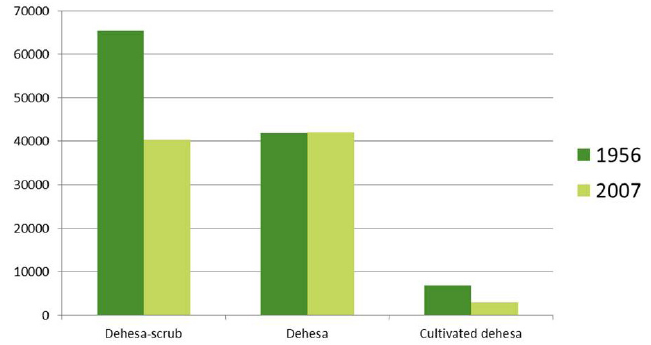
Figure 3: Changes in the three main types of dehesa (hectares). Source: Geodatabase created by the